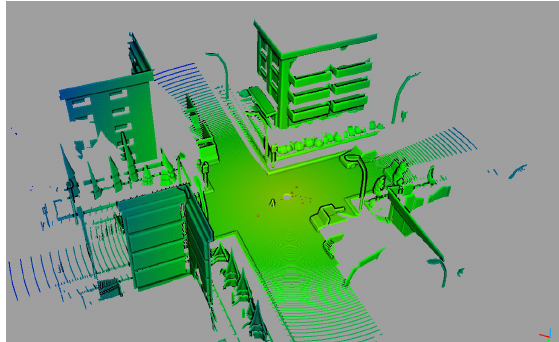
Figure 5: Example of a point cloud generated by the